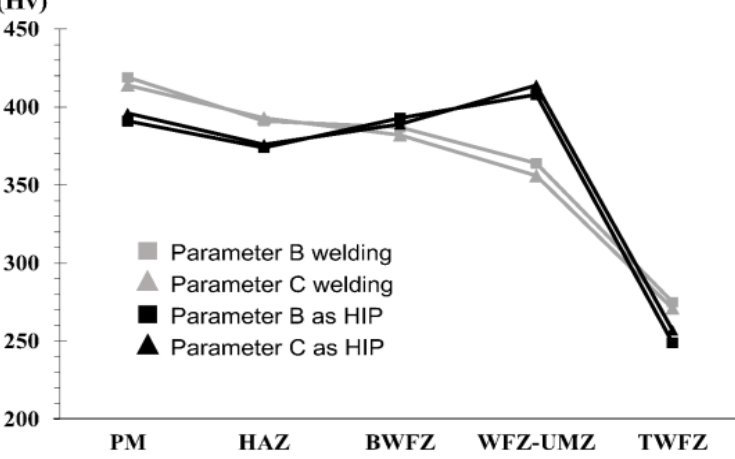
Figure 6. Hardness in the various regions of the repaired welds before and after the HIP processes